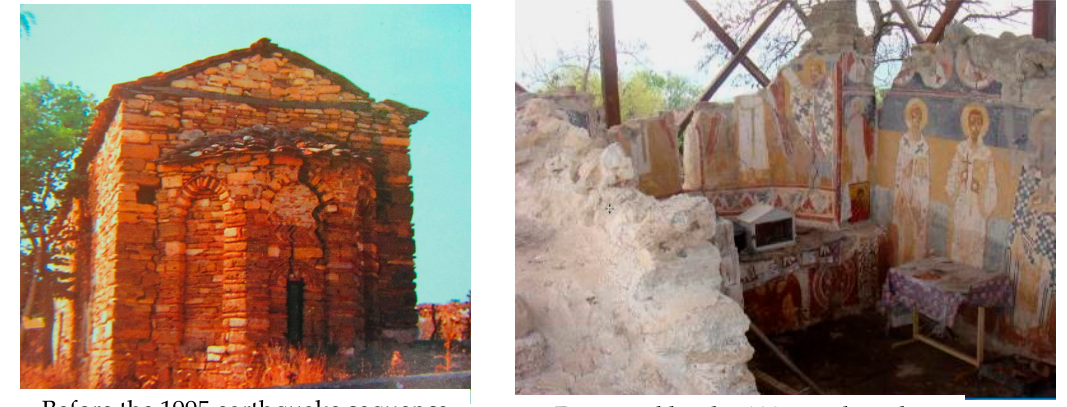
Figure 23. The church of Taxiarchis in Eani, Kozani prefecture.